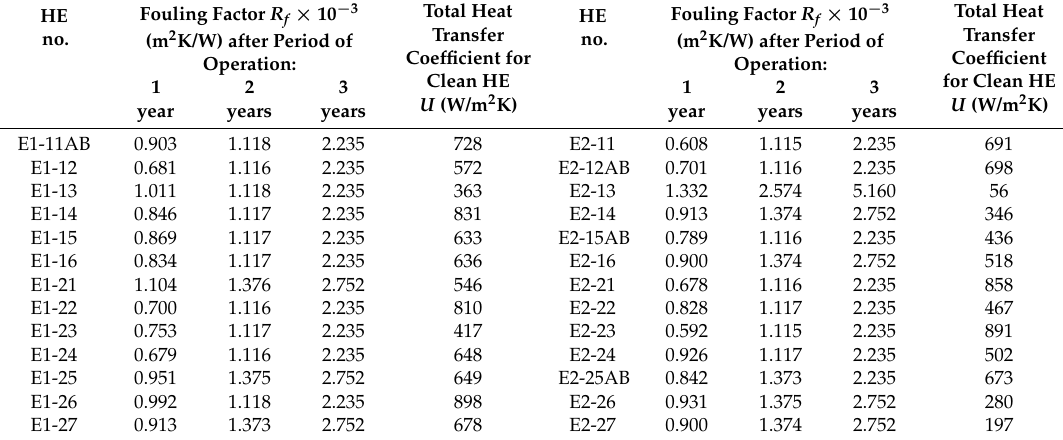
Table 1. Values of the R f and heat transfer coefficient for the studied HEN in case no. 1. HE